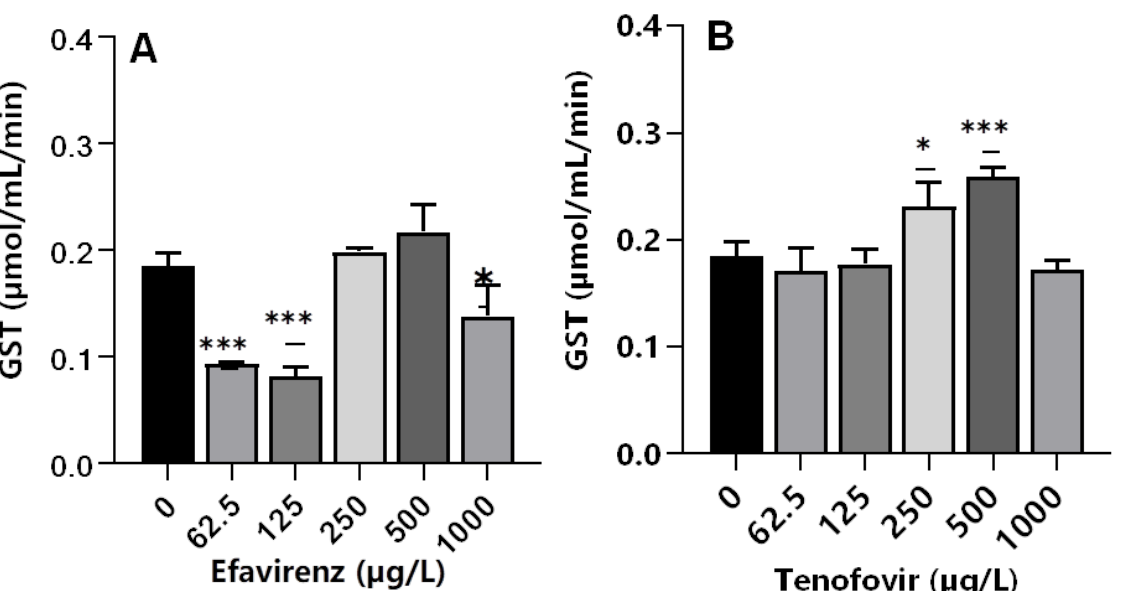
Figure 3. GST levels in D. magna exposed to ( A ) EFV, and ( B ) TFV for 48 h. Values are presented as mean ± standard deviation ( n = 3); (Asterisks (*) denote significant differences (one-way ANOVA followed by Dunnett’s multiple comparisons test (* p <0.05, *** p ≤ 0.001)) between ARVs-exposed samples and the controls.